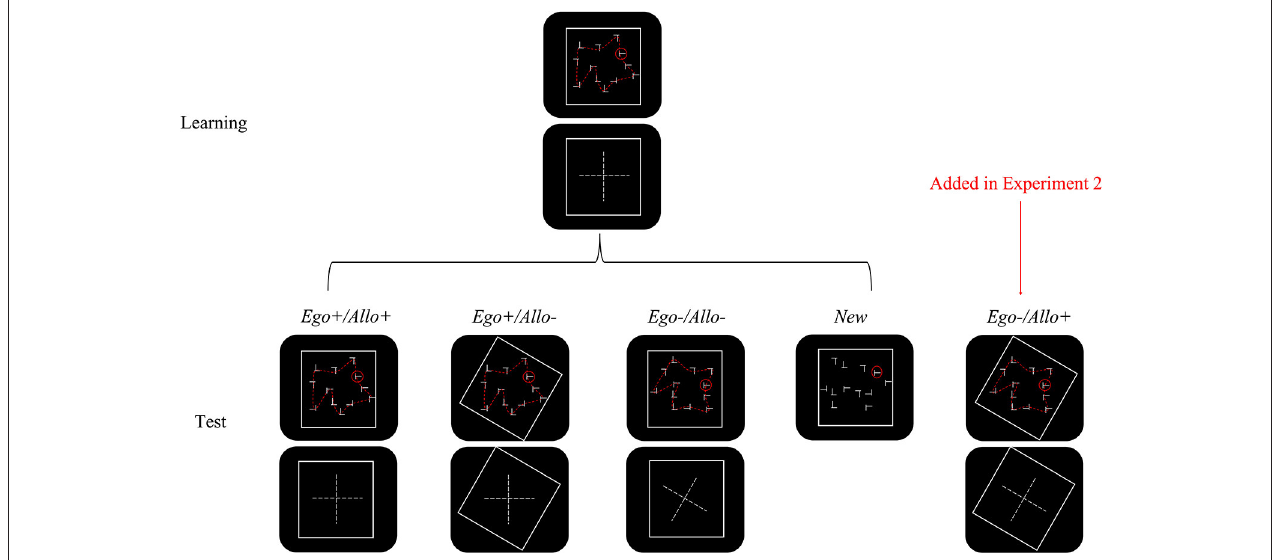
FIGURE 1 | Schematic drawing of the configurations in Experiment 1 and 2. A schematic drawing panel briefly describes the displays (the cross in the middle represents the search display’s configuration relative to the learning phase). Configurations in the new condition were newly generated, so there is no schematic drawing for them. The rightmost column represents one condition newly added in Experiment 2. In the actual experiment, all dash lines and the schematic drawings were not visible. For details see the section Methods.